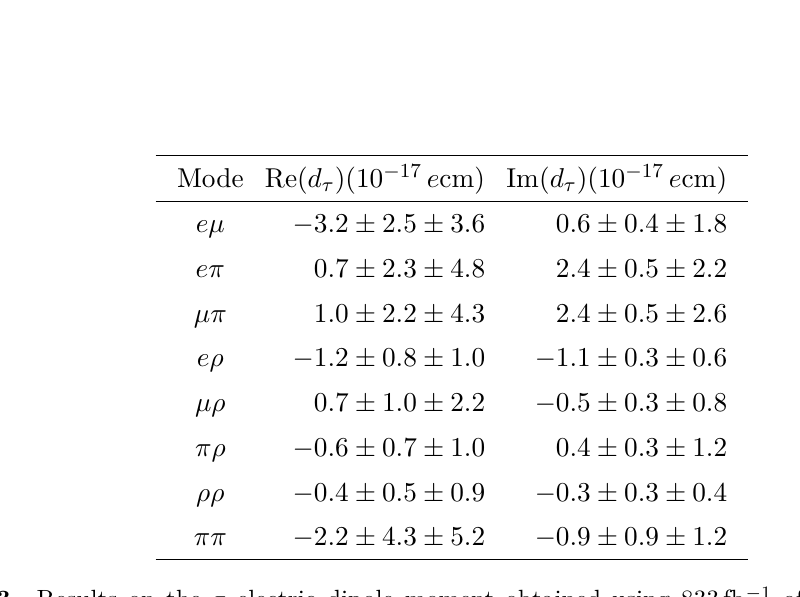
Table 3 . Results on the τ electric dipole moment obtained using 833 fb − 1 of data. The first uncertainties are statistical and the second ones are